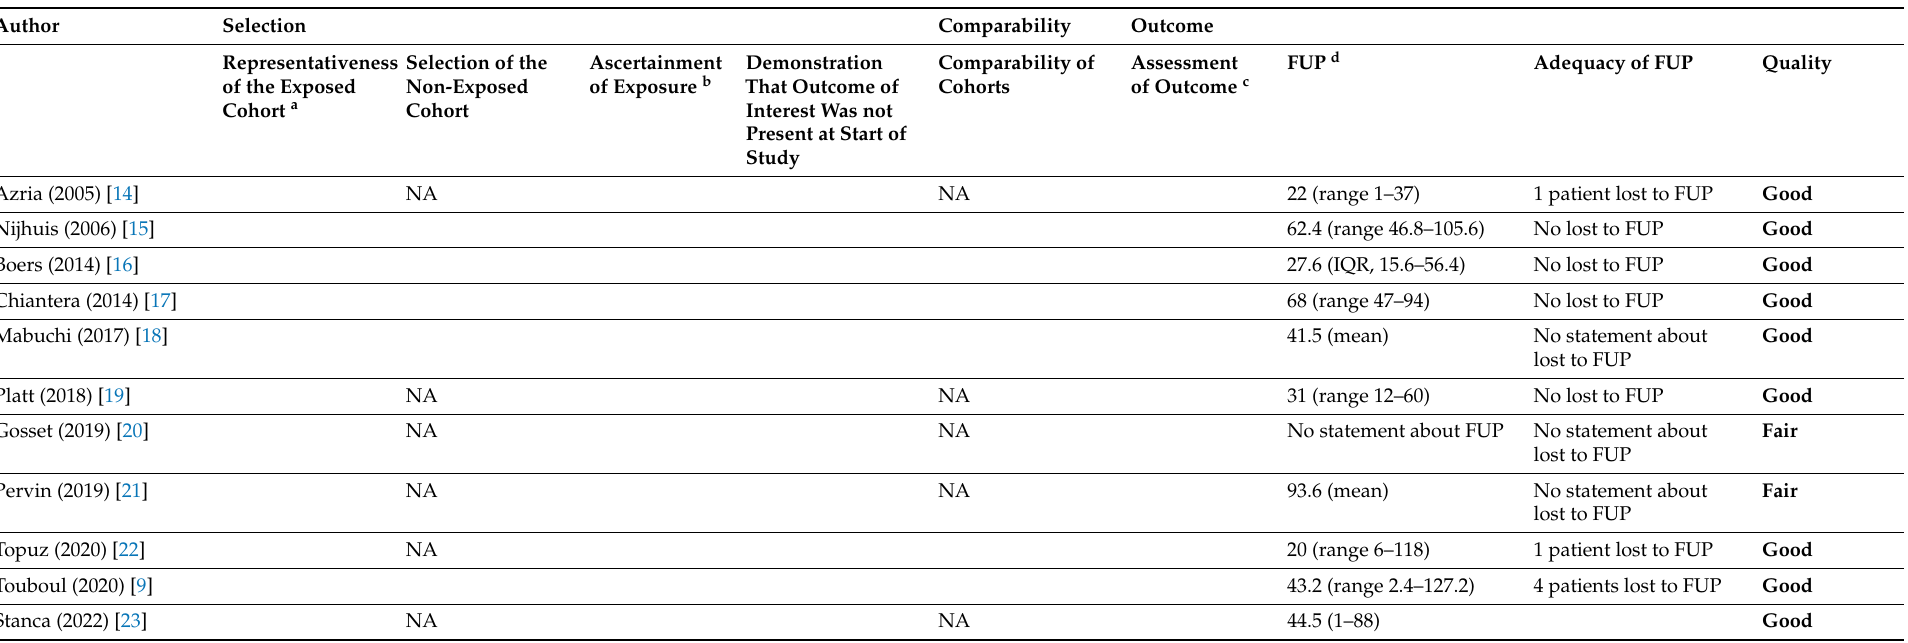
Table 1. Newcastle–Ottawa Scale for cohort studies included in the analysis